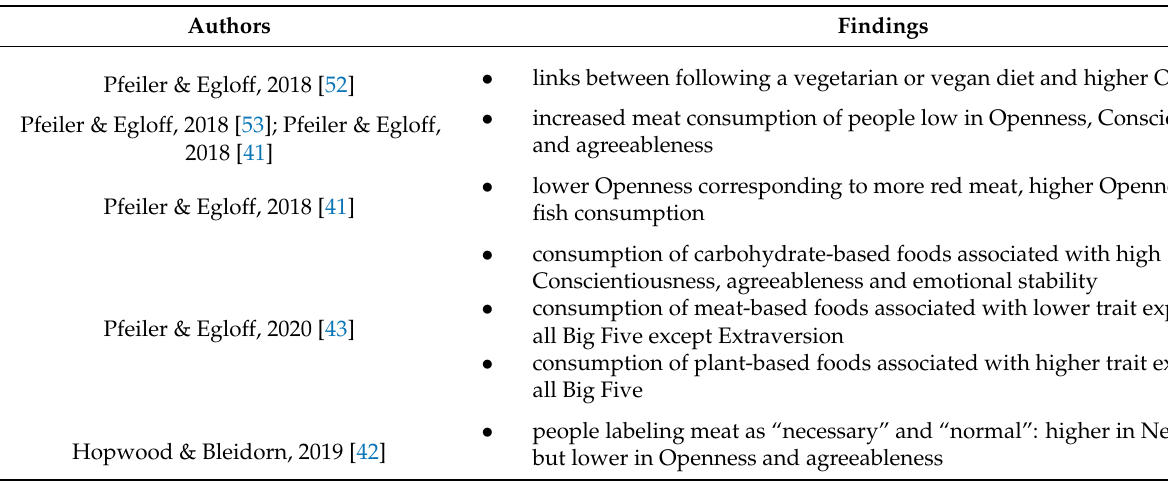
Table 1. Links between the Big Five and eating